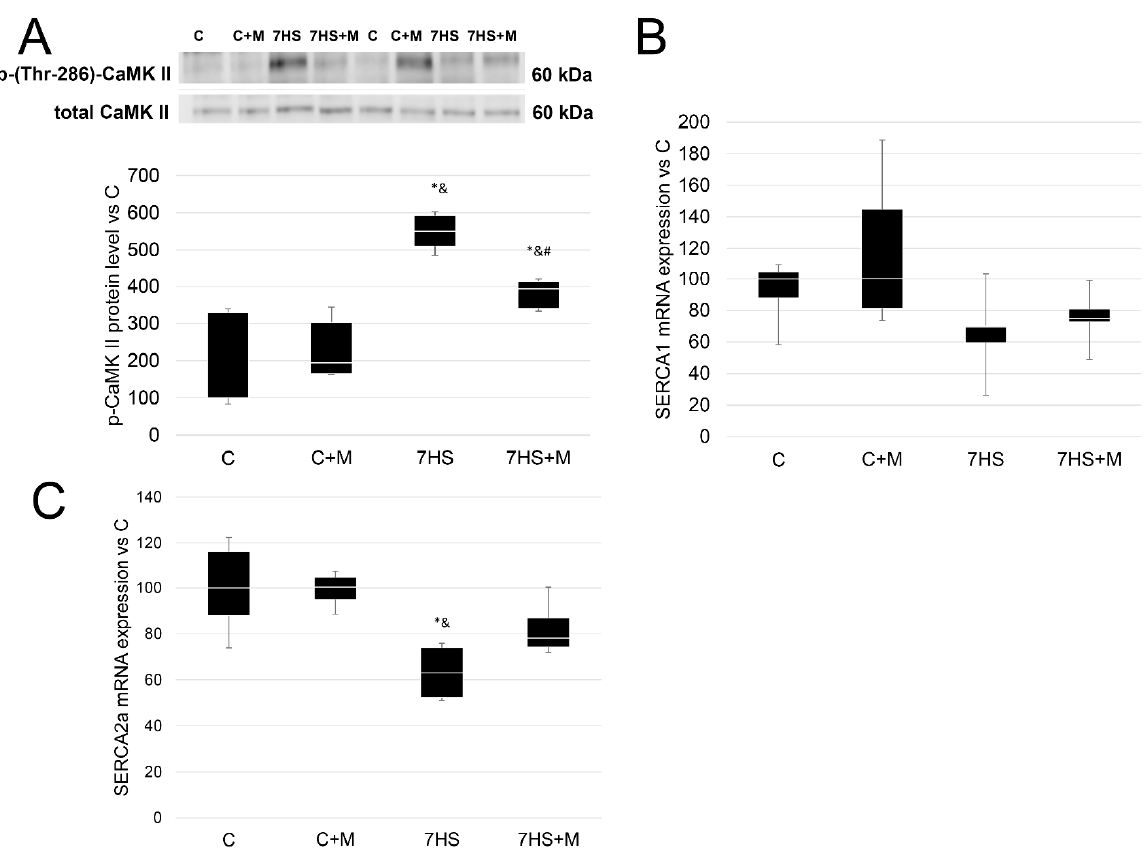
Figure 8. Western blot of p-(Thr286)-CaMK II (beta)/total CaMK II (beta) protein level ( A ), and RT-PCR of SERCA1 ( B ) and SERCA2A mRNA expression in control group ( C ), control group with metformin (C+M), 7-day hindlimb-suspended group (7HS), and 7-day hindlimb-suspended group with metformin (7HS+M). Data are shown as % of the control group and median of the C group has been arbitrarily set to 100%. *—significant difference from the control group. &—significant difference from C+M group. #—significant difference from 7HS group ( p < 0.05). Box plots show 25–75 percentiles and median values and the whiskers represent the minimum and the maximum; n =